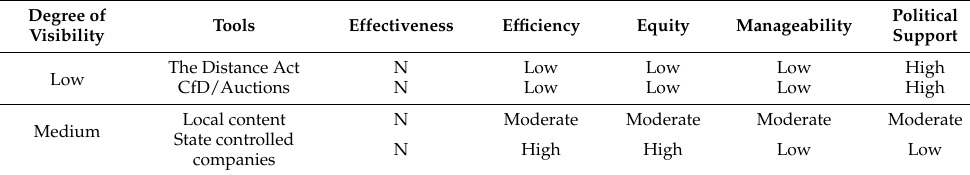
Table 7. Degree of visibility.